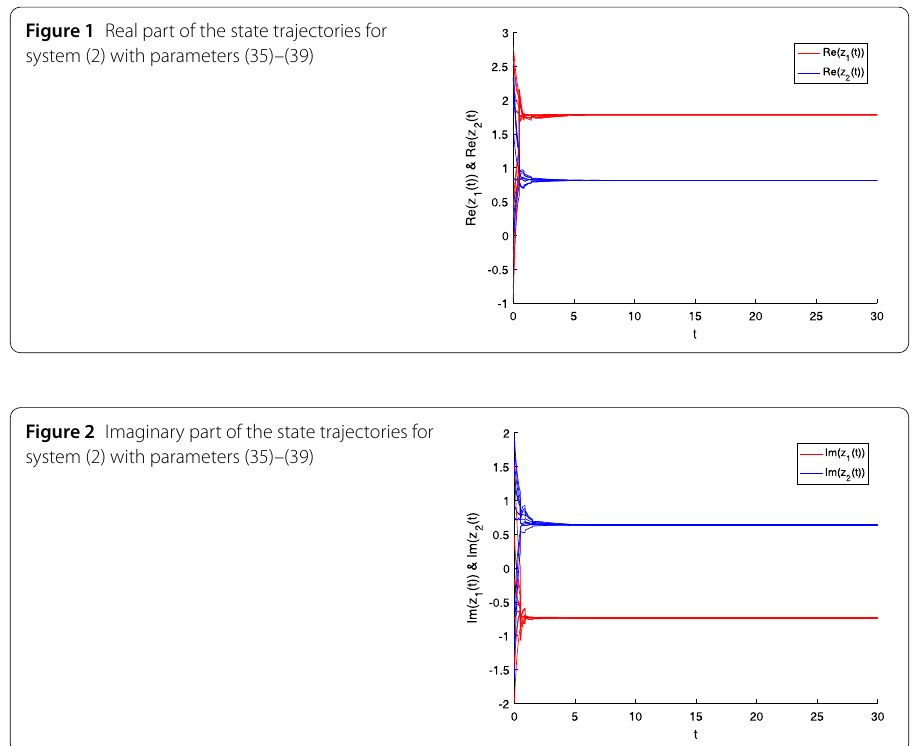
Figure 2 Imaginary part of the state trajectories for system (2) with parameters